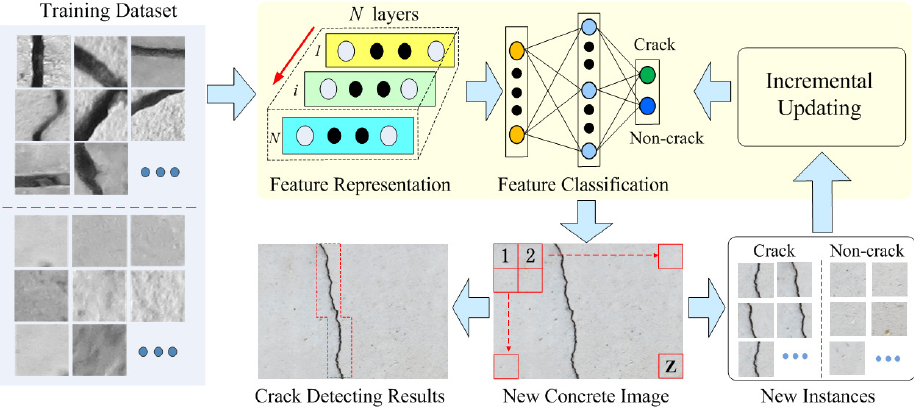
Figure 2. Schematic diagram of the presented concrete crack region detecting